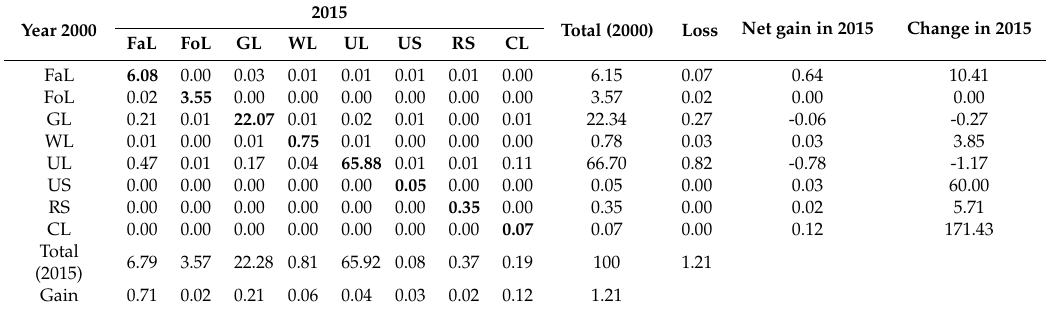
Table 1. Transitions in percentages of the total LUCC observed during 2000–2015